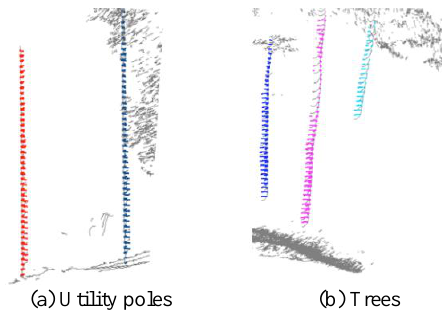
Figure 10. Segmentation of section